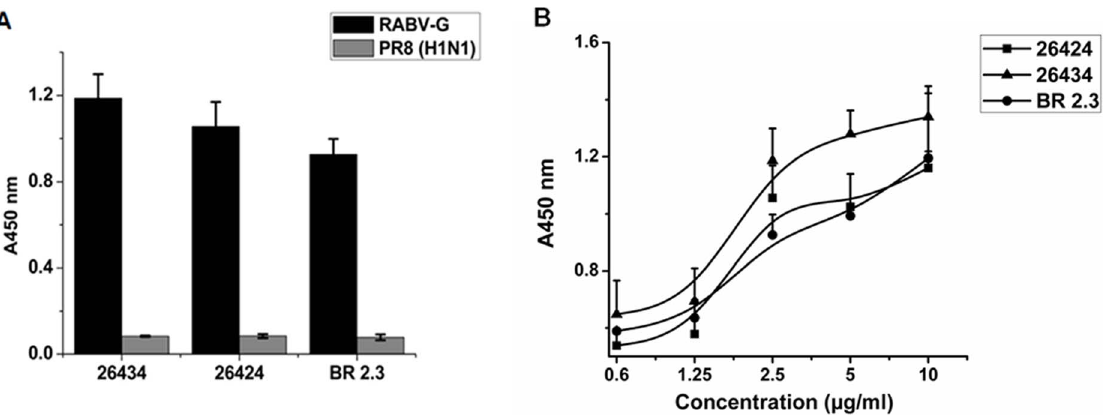
Figure 4. Binding of 26424, 26434 and BR 2.3 in ELISA to RABV. (A) The combodies, 26424 and 26434, and BR 2.3 (control monovalent sdAb) were analyzed in a binding ELISA to confirm their specificity to RABV (inactivated). PR8 (H1N1) was used as the negative control to determine cross- neutralization of the sdAbs. The graph depicts binding specificity of 26424, 26434, and BR 2.3 at a concentration of 2.5 m g ml 2 1 . (B) Binding of 26424, 26434 and BR 2.3 to RABV at different concentrations of the purified sdAbs. Mouse anti- myc IgG was used as primary antibody followed by HRP- labeled goat anti-mouse IgG. The binding reactivity was confirmed in four independent experiments and the figure represents the average value. Mean 6 standard deviations (SD) for each sample at different dilutions have been depicted.